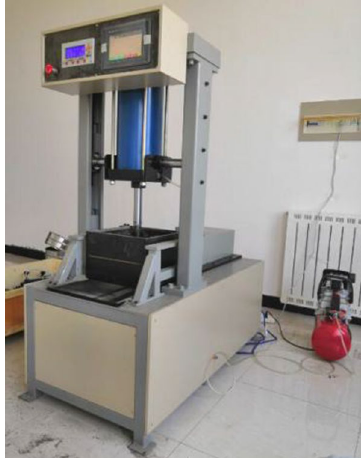
Figure 1. Test device.